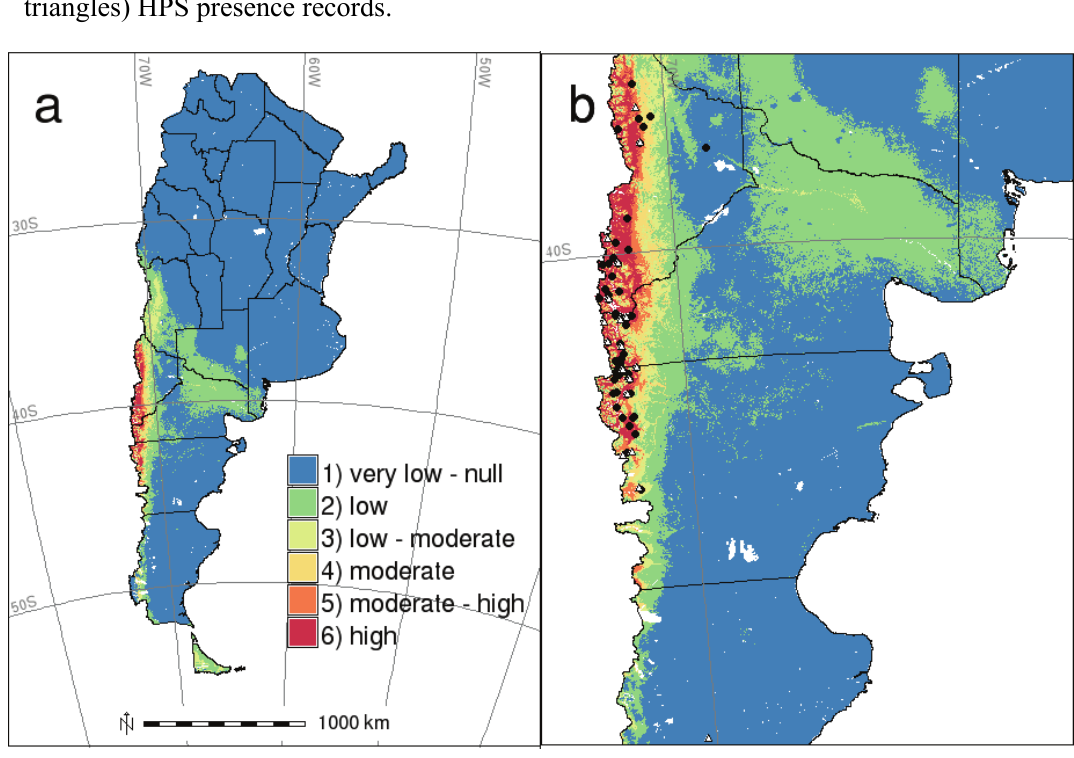
Figure 4. ( a ) Risk map for HPS caused by Andes virus in southern Argentina; ( b ) zoomed map of Patagonia covering HPS occurrence. Training (black circles) and test (white triangles) HPS presence